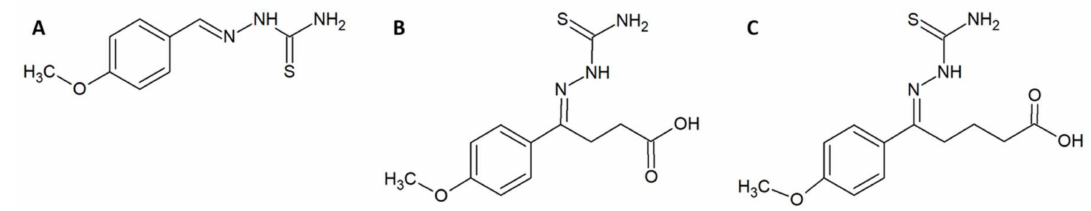
Figure 3. Chemical structures of ( A ) compound ‘2B’. ( B ) compound ‘5A’. ( C ) compound